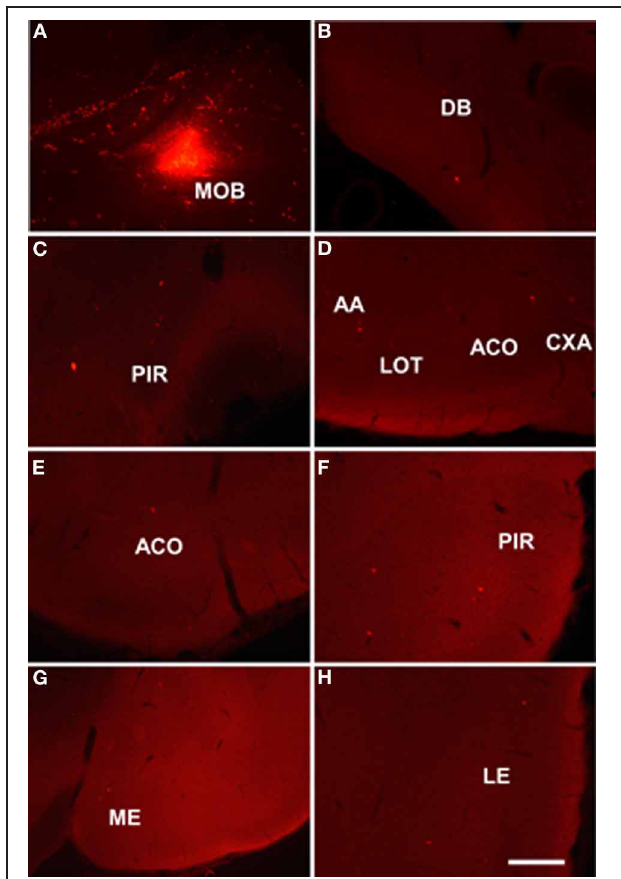
FIGURE 3 | Sagittal (A) and coronal sections (B–H) from rostral to caudal levels of the telencephalic hemisphere showing the resulting labeling (B–H) after a dextran-amine labeled tetramethylrhodamine injection in the rat accessory olfactory bulb (A). Abbreviations: BAOT, bed nucleus of the accessory olfactory tract; BST, bed nucleus of the stria terminalis; CA1, CA1 field of the hippocampus; DB, nucleus of the diagonal band; ME, medial amygdala; PIR, piriform cortex; PMCO, posteromedial cortical amygdala; VS, ventral subiculum. Scale bar for A : 800 μ m, B–H : 400 μ